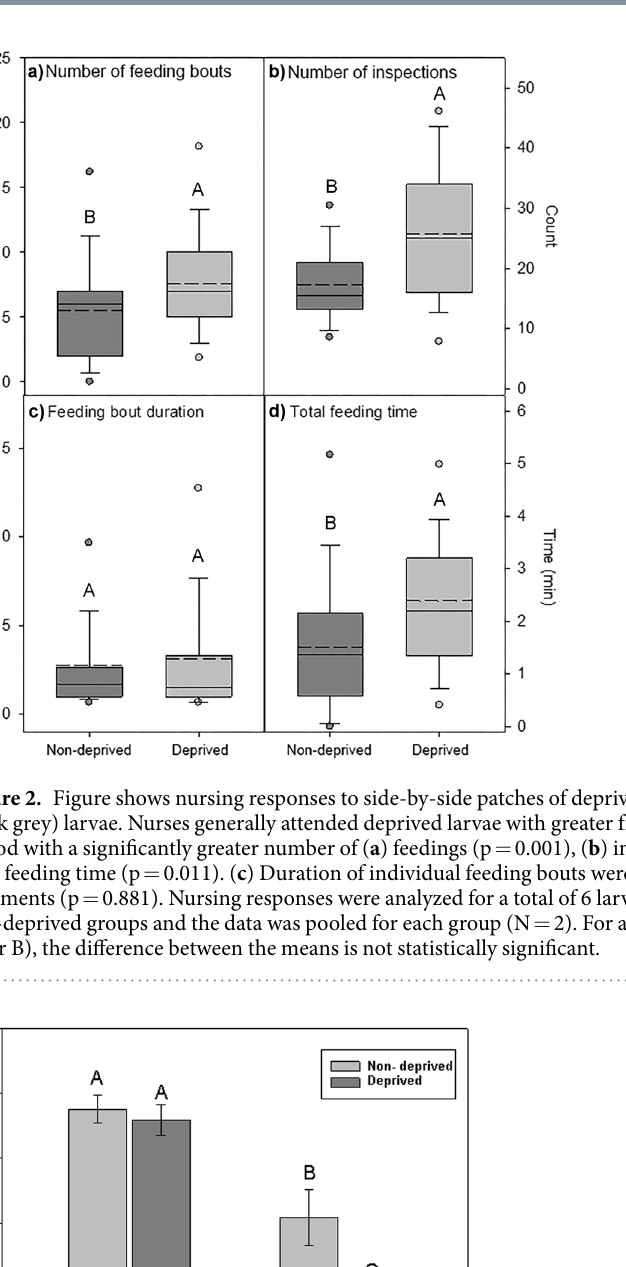
Experiment 5. Effects of relatedness and nutritional status on selection of larvae for queen rearing. experimental colonies headed by unrelated, open mated queens, and again with colonies headed by single drone